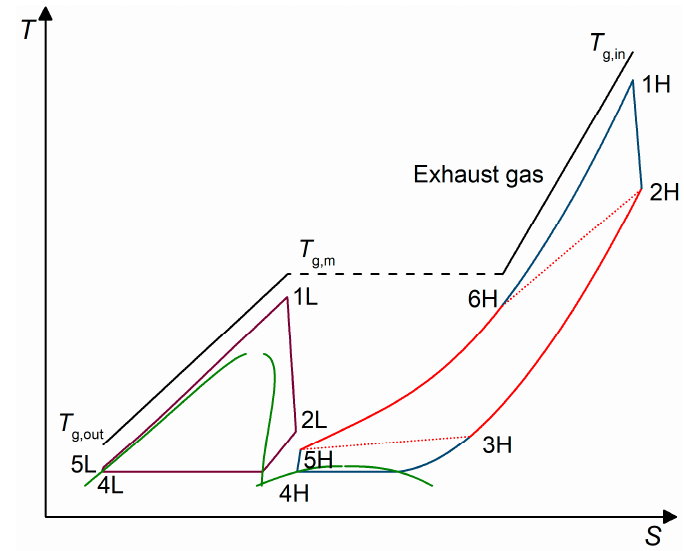
Figure 2. Schematic diagram of CO 2 -TC+OTC combined system.